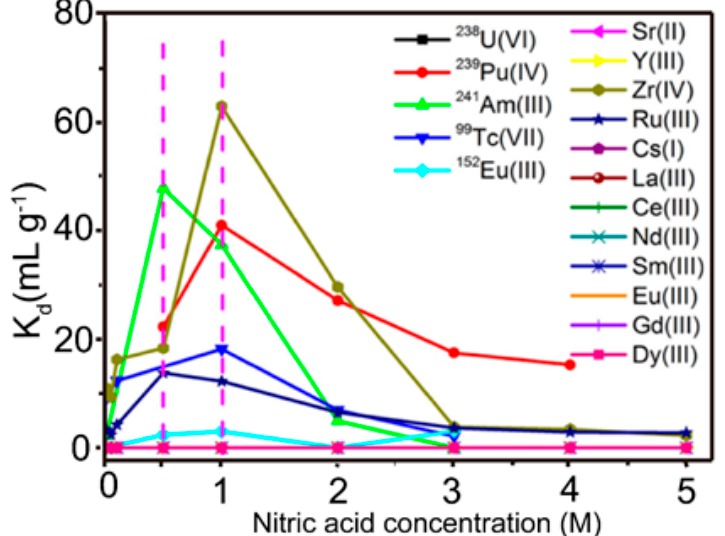
Figure 16. Chemical structure of CA-BTP (bis-2,6-(5,6,7,8-tetrahydro-5,9,9-trimethyl-5,8-methano